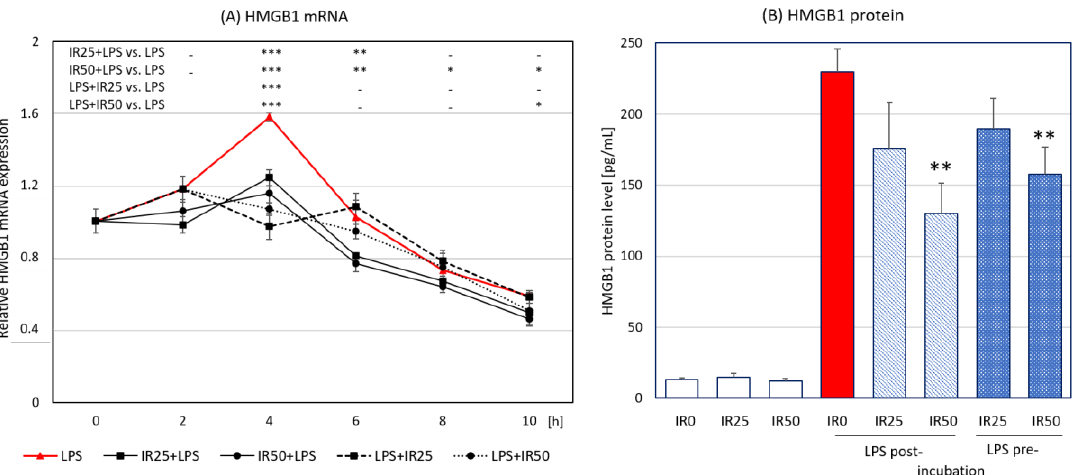
Figure 5. The time-course of high-mobility group box 1 (HMGB1) expression and release in LPS-stimulated RAW 264.7 macrophages after irisin (IR; 0, 25, or 50 nM) before or after lipopolysaccharide (LPS; 100 ng/mL) treatment: ( A ) kinetics of HMGB1 mRNA expression and ( B ) HMGB1 protein expression released 24 h after LPS stimulation. Irisin was administered 2 h before (IR + LPS) or after LPS treatment (LPS + IR). Results are presented as the mean with standard deviation; n = 4–5. Statistically significant differences were calculated in relation to the IR0 + LPS group, used as a control group: * p < 0.05; ** p < 0.01; *** p < 0.001; “-“ not statistically significant.